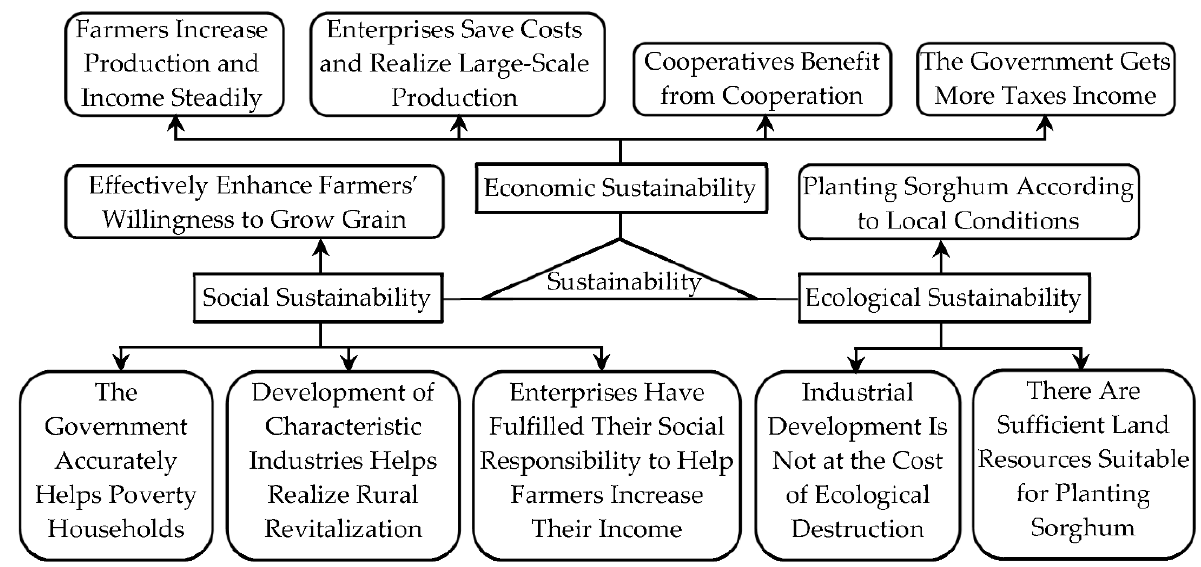
Figure 5. Sustainability of Poverty Alleviation Characteristic Industry of Sorghum Planting in Luquan County.